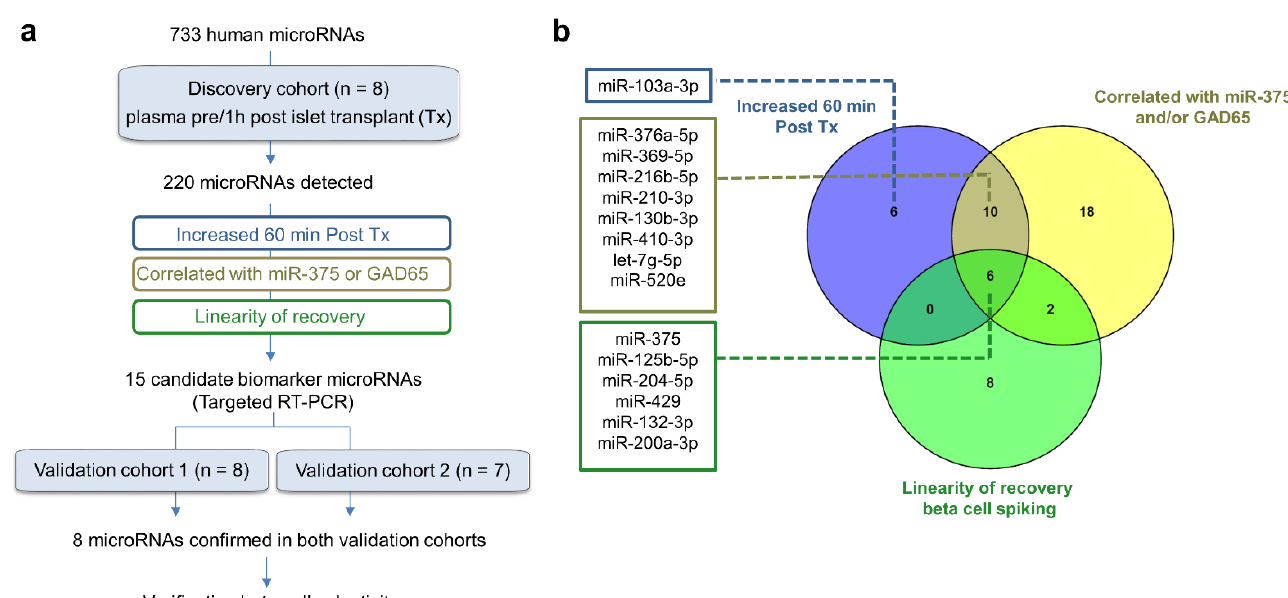
Figure 1. Study design. ( a ). Plasma samples before and 1 h after intraportal islet transplantation (Tx) were arrayed by hydrolysis probe PCR for presence and relative level of 733 human microRNAs in a discovery cohort of 8 subjects transplanted in Brussels. After stringent data filtering, 220 microRNAs were confidently detected and analyzed for differential levels before and after transplantation. A further selection of likely beta cell-enriched microRNAs was done by identifying microRNAs that showed NRQ levels that correlated with plasma GAD65 and/or miR-375 as measured by calibrated quantitative assays; and/or that show a linear response to the number of beta cells spiked into a control plasma pooled sample in a recovery experiment. This led to the composition of a panel of 15 candidate biomarker microRNAs that was subjected to blinded verification by targeted hydrolysis-probe PCR in two independent validation cohorts of 8 patients transplanted in Brussels (validation cohort 1) and 7 patients transplanted in Milan (validation cohort 2). ( b ). The Venn diagram shows the 22 microRNAs that were significantly increased after islet transplantation in the discovery cohort, the 16 microRNAs that increased proportionately to the number of beta cells spiked in the recovery experiment and the 36 microRNAs of which post-transplant NRQ correlated positively with miR-375 and/or GAD65. The 15 microRNAs selected as candidate biomarkers for blinded validation are listed left of the Venn diagram. Finally, microRNAs confirmed in the validation cohorts were additionally analyzed for possible beta cell selectivity by tissue-comparative PCR analysis. Table 1. Panel of 15 candidate microRNA biomarkers of beta cell destruction identified in the discovery cohort and sub- jected to independent blinded validation. The table lists, from left to right, the microRNA name and corresponding TaqMan ® hydrolysis probe used for targeted confirmation, the average Normalized Relative Quantity (NRQ) after global mean normalization, and the Spearman Rank correlation coefficient to plasma GAD65 and miR-375 of the 15 candidate biomarker microRNAs selected, as shown in Figure 1 in the discovery cohort ( n = 8). Right columns show the average Relative Quantitity (RQ) after versus before transplantation and the corresponding p -value (paired student t -test) in the independent validation cohort 1 (Brussels, n = 8) and validation cohort 2 (Milan, n = 7). ND: not detected. Tx: islet trans- plantation.